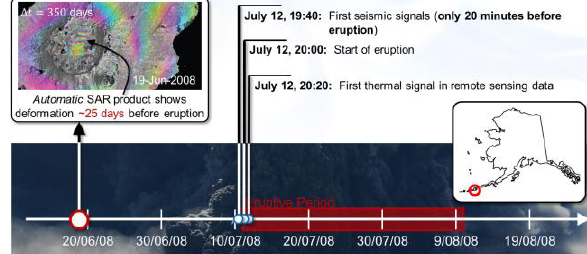
Figure 8. Timeline of the eruption at Okmok volcano in 2008 together with the timeline of hazard alerts. The chart shows that no pre-eruptive signatures could be detected by thermal and multi-spectral remote sensing data. First eruptive indicators were detected by seismic stations only 20 minutes prior to the start of the eruption. The addition of SAR would have improved the warning period from 20 minutes to 25